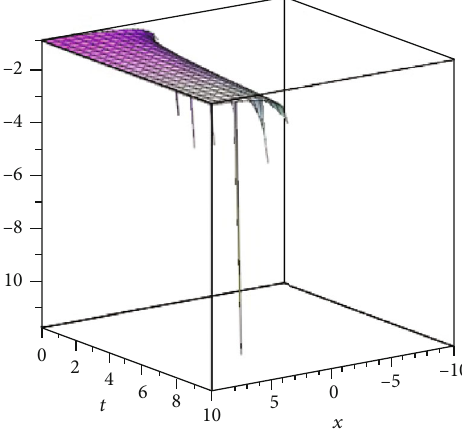
ð x , 0, t Þ of Equation (21). Figure 5: u 1,5